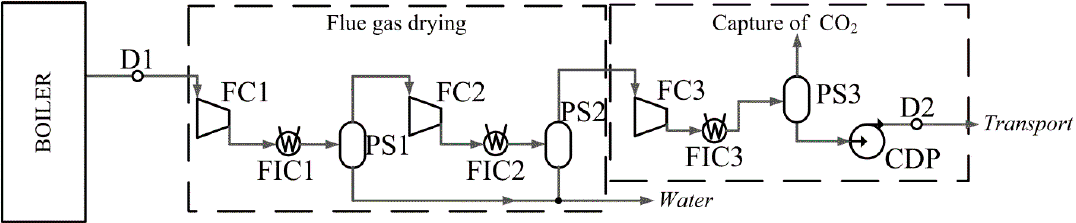
Figure 3. Scheme of the CO 2 capture and compression unit (CDP–condensed CO 2 pump; FC–flue gas compressor; FIC–flue gas intercooler; PS–phase separator).